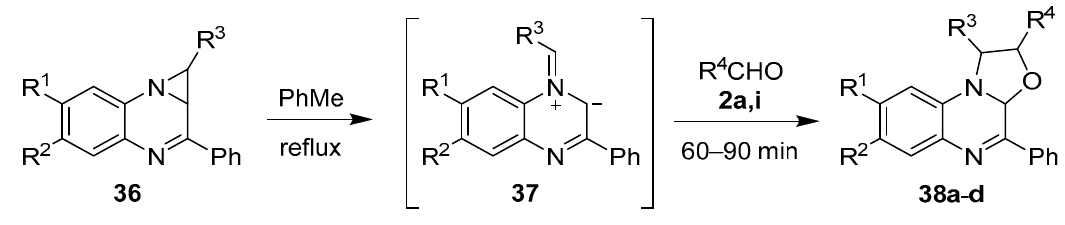
Table 4. Cycloaddition of azomethine ylide 37 to aromatic aldehydes 2a and 2i (Scheme 7).